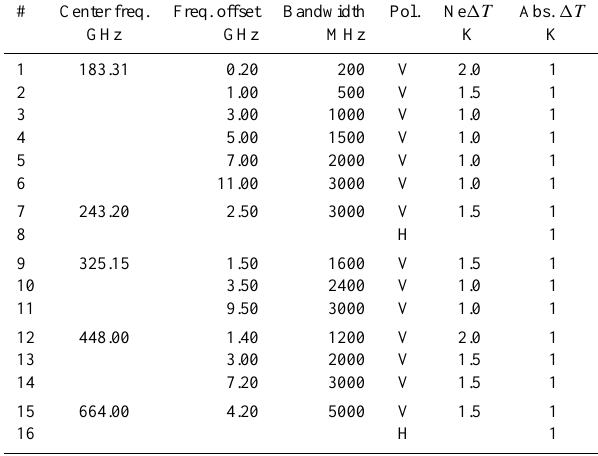
Table 3. CloudIce channel specifications and radiometric require- ments. Ne 1T is the random error in the measurement, due to radio- metric noise. Abs. 1T is the absolute error in the